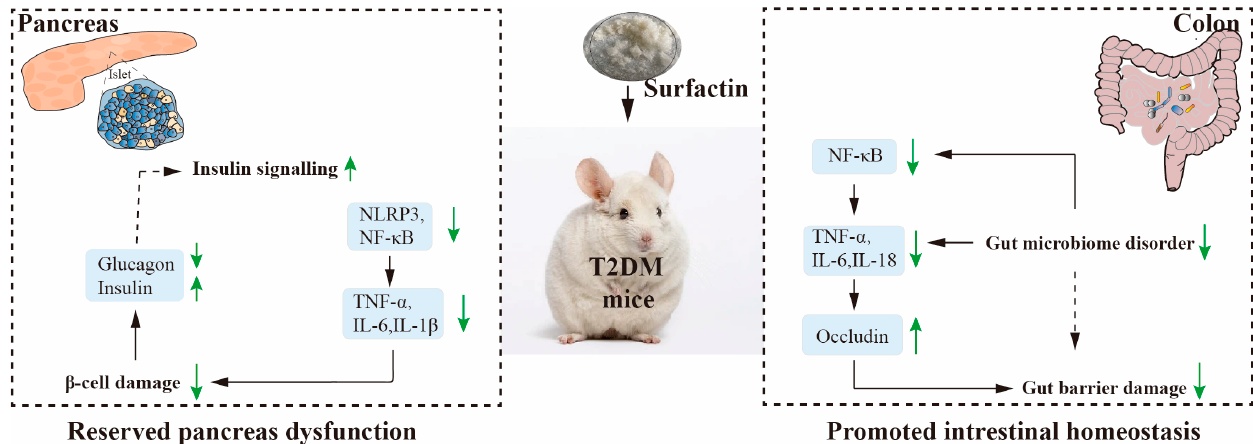
Figure 9. Potential mechanism by which surfactin alleviates T2DM. Green signifies (up) increased parameters, metabolites, or proteins, green signifies (down) decreased parameters, metabolites, or proteins in the surfactin group.